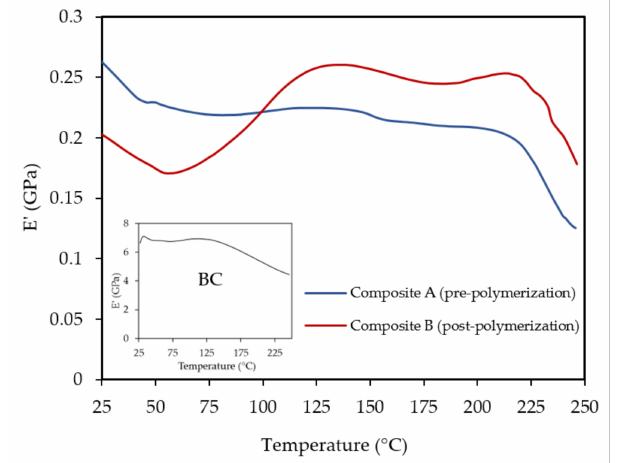
Figure 2. Evolution of the storage modulus (E’) versus temperature at 1 Hz for BC (inserted graph) and BC composites as obtained by dynamic mechanical